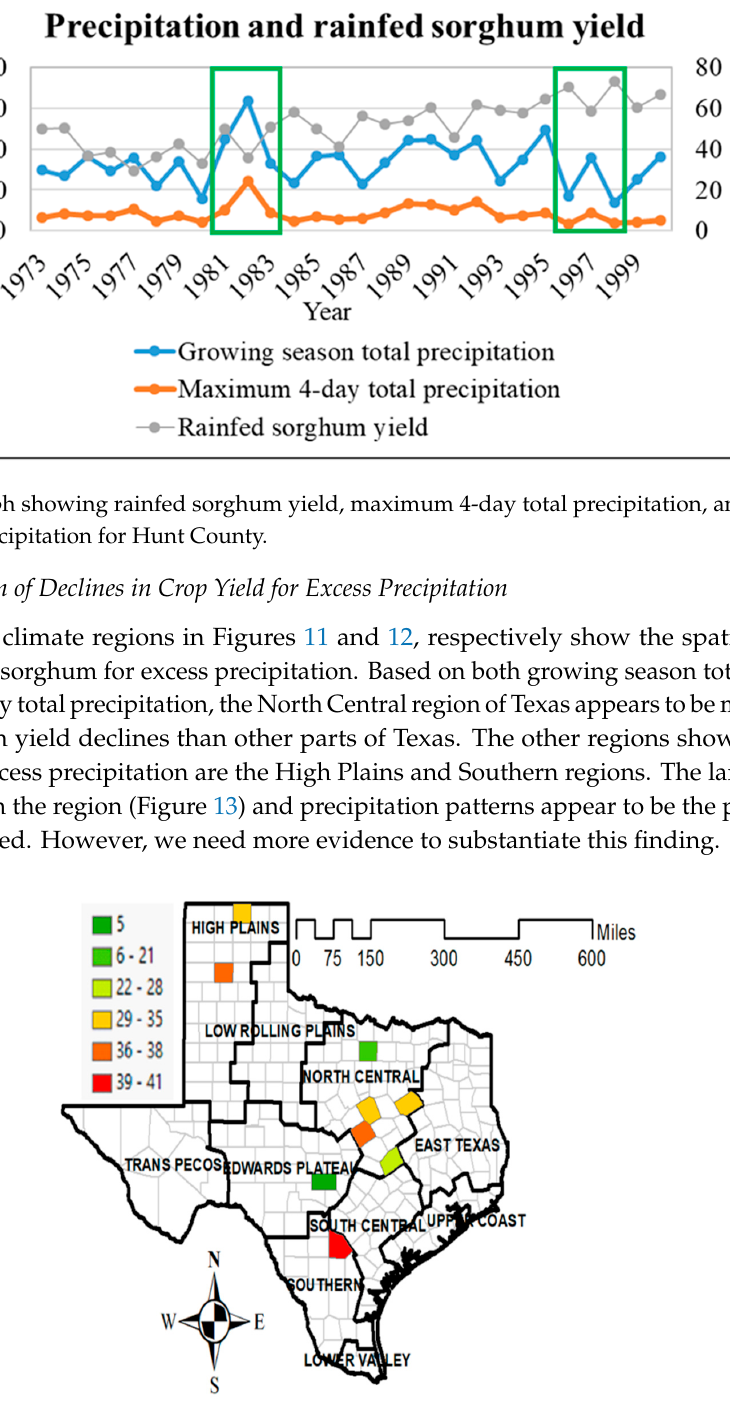
Figure 11. Percent reduction in rainfed sorghum yield between the year with excess precipitation and average crop yield from 1973 to 2000 (based on growing season total precipitation).